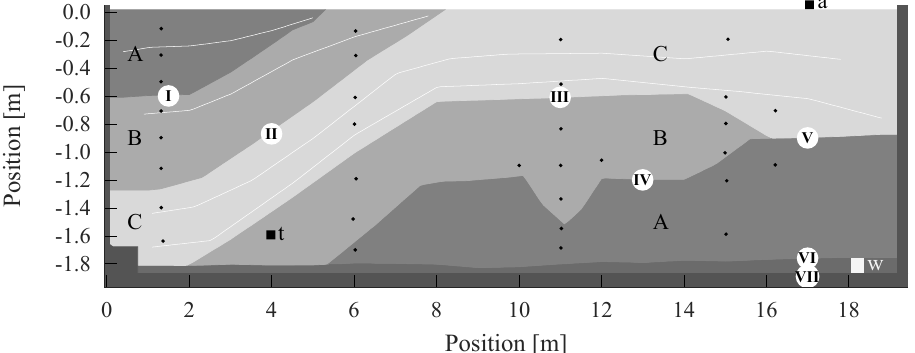
Figure 1. ASSESS provides an effectively 2-D subsurface architecture consisting of three kinds of sand (A, B, and C). During the experiment that is evaluated in this work, the groundwater table was manipulated via a groundwater well (white square at 18 . 3m). The resulting hydraulic dynamics were monitored automatically with a stationary GPR antenna (black square at 17 . 05m), a tensiometer (black square, at 4 . 0m), and 32 TDR sensors (black dots). A gravel layer below the sands allows for a rapid water pressure distribution at the lower boundary of the site. An L-element (left wall, at 0 . 4m) and compaction interfaces (white lines) result from the construction of the site. Additionally to those visualized, GPR evidence indicates additional compaction interfaces (Fig. 14) that were not determined during construction. Roman numerals (I)–(VII) indicate material interfaces referred to in the text. Note the different scales on the horizontal and vertical